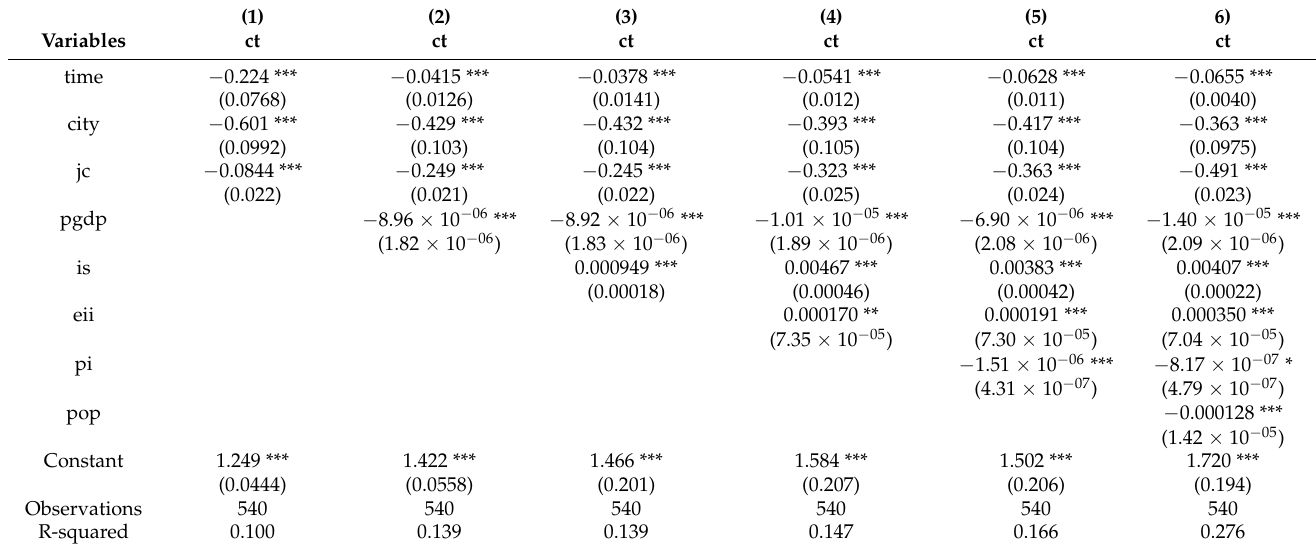
Table 5. Effect of carbon trading policy implementation on economic growth—difference in differ- ences